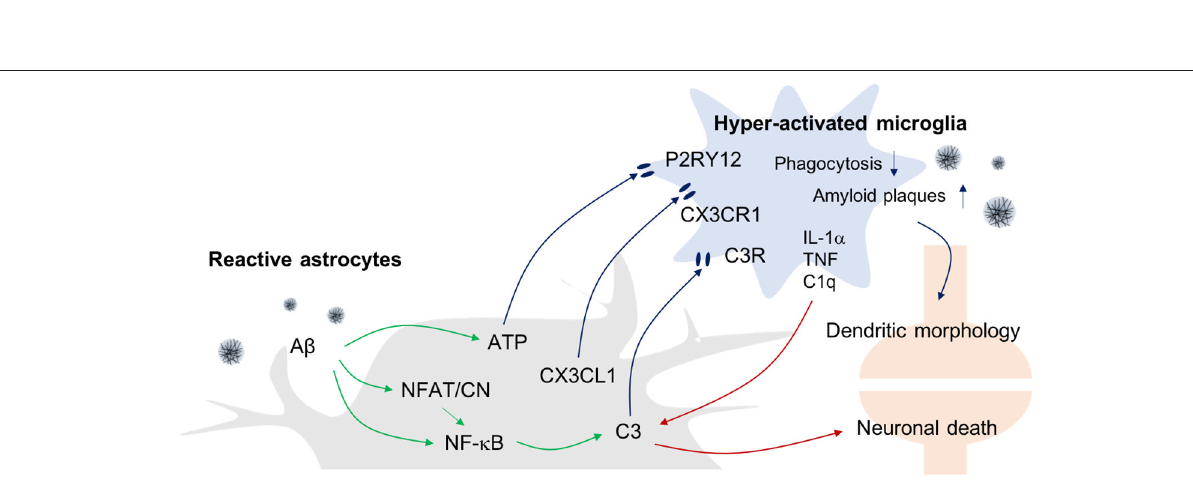
glycogen synthase kinase 3 beta (GSK-3 β ) paradoxically do not exhibit